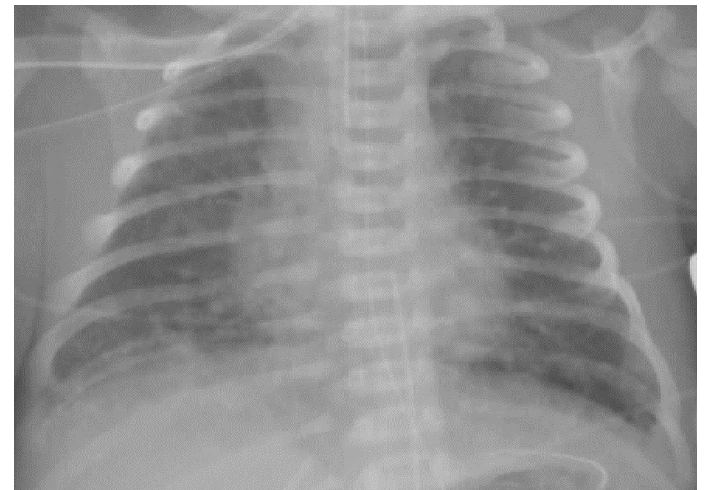
Figure 2. Chest X-ray of meconium aspiration syndrome.